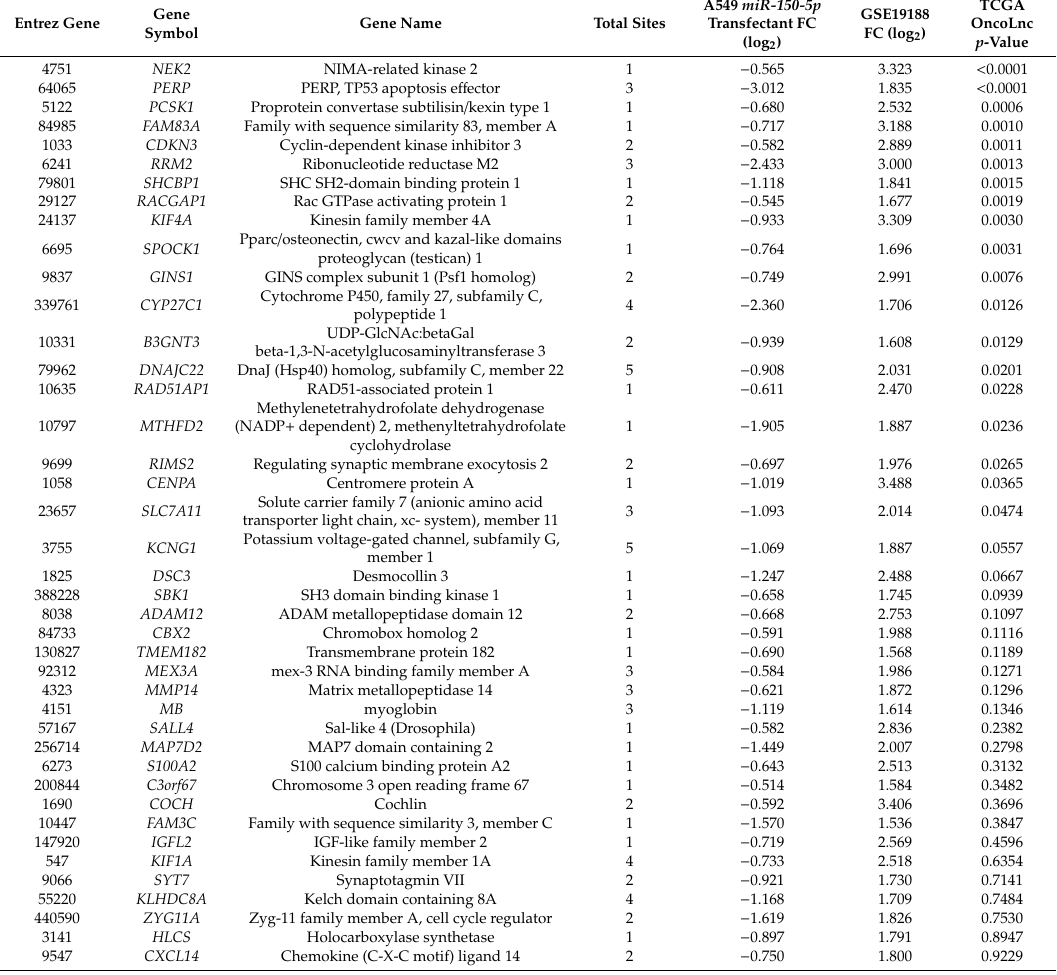
Table 2. Candidate target genes regulated by